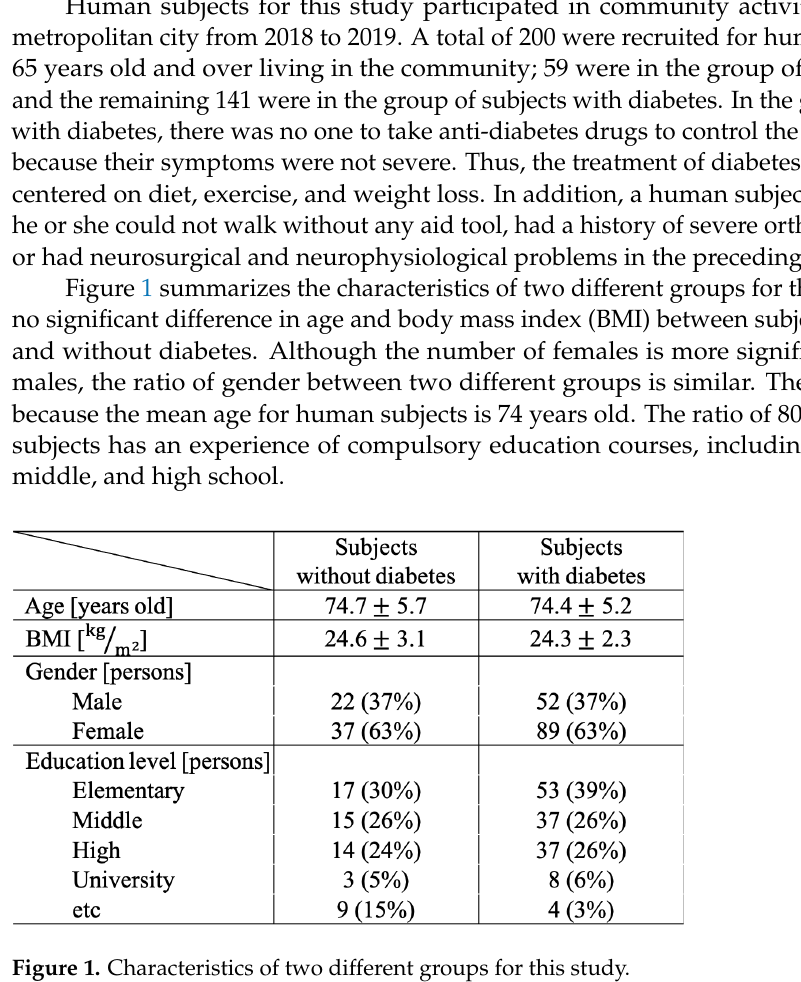
Figure 1. Characteristics of two different groups for this